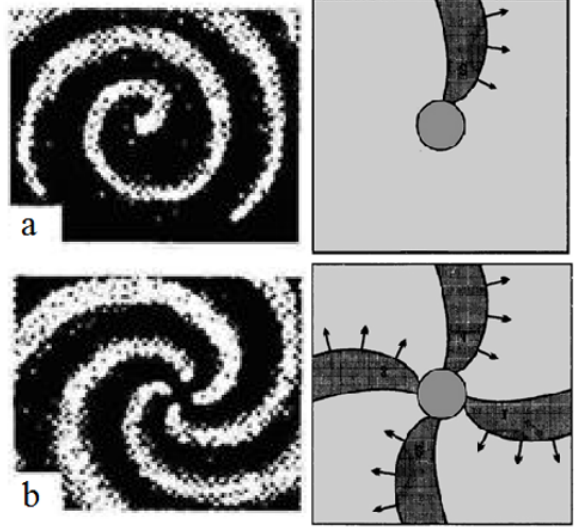
Fig. 1. Spiral waves in a chemically active medium with the values of topological charges equal to 1,4, on the left. The schematic motion of the front (shown in black) of the spiral wave is shown on the